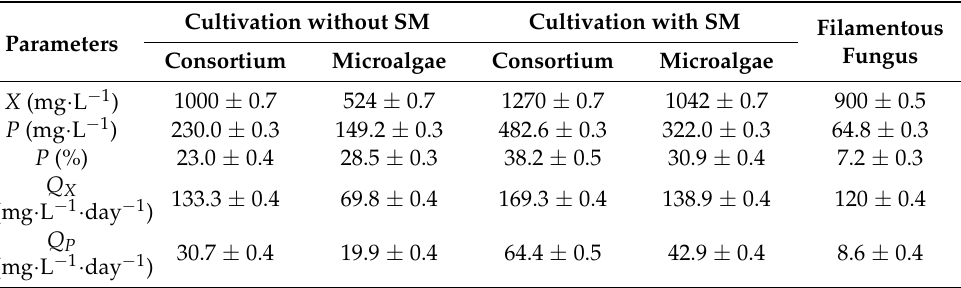
Table 1. Biochemical parameters resulting of the cultivation of the strains microalgae S. obliquus, fungus M. circinelloides and their consortium—without and with the addition of sugarcane molasses (SM) to the microalgae culture